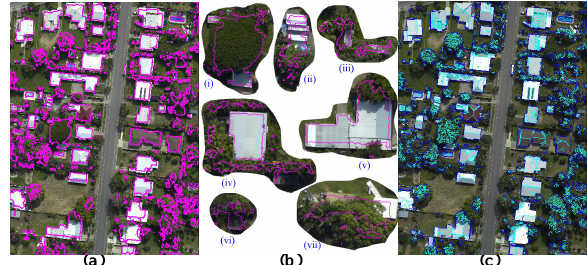
Figure 3. (a) Building boundaries detected after CCA, (b) False boundary delineation, and (c) Segmented lines (edges and ridges)